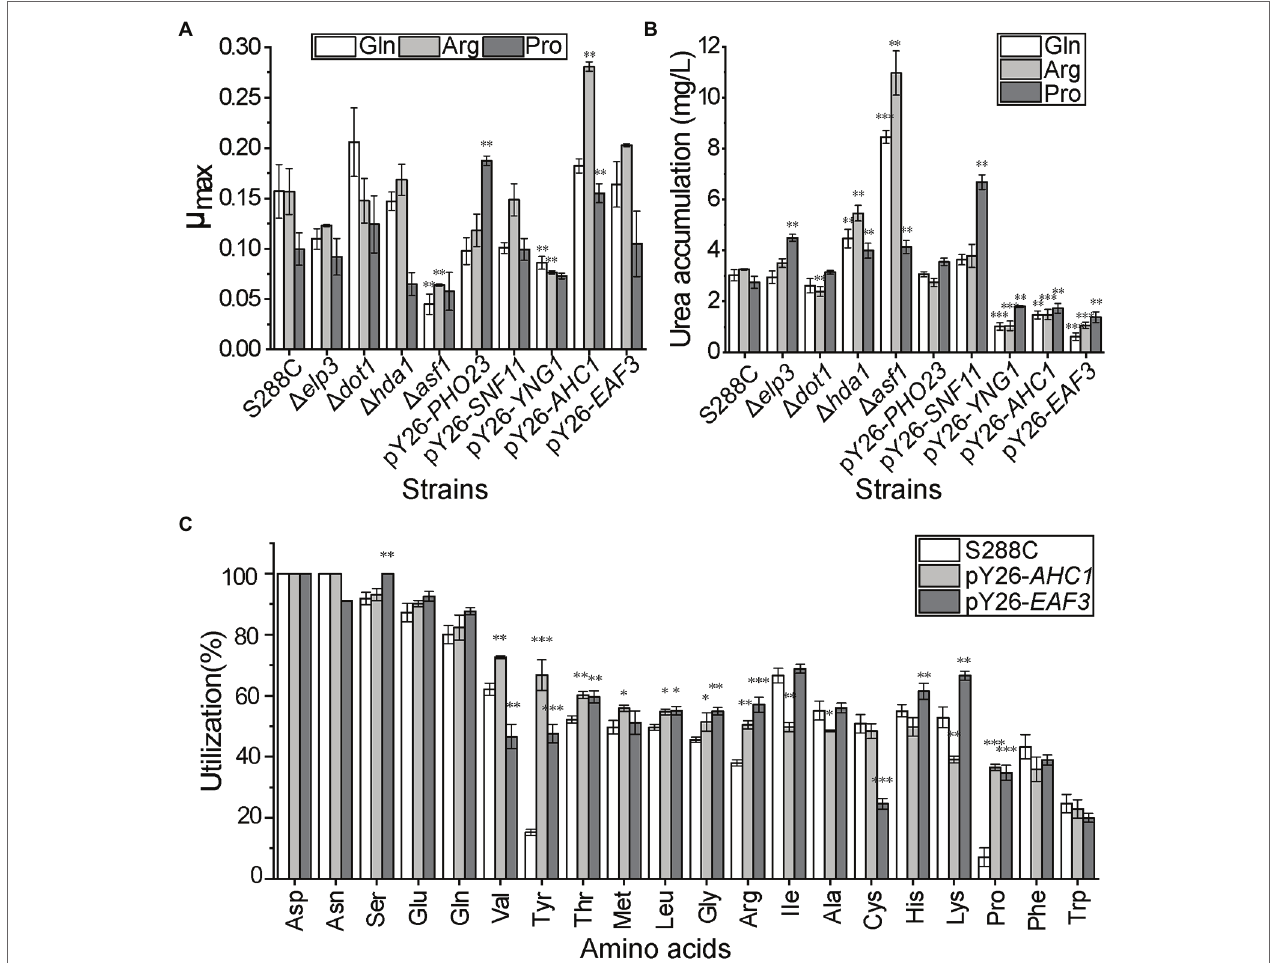
FIGURE 3 | Physiological index analysis of CRs recombinant strains. (A) Growth status of nine CR recombinant strains in the presence of different nitrogen sources. (B) Urea accumulation in nine CR recombinant strains in the presence of different nitrogen sources. (C) Amino acid utilization rate of S288C-pY26- AHC1 and S288C-pY26- EAF3 in mixed medium containing the 20 common amino acids. Results are mean (M) ± standard deviation (SD) of three biological replicates. Statistical significance was determined by unpaired parametric two-tailed Welch’s t -test with 95% confidence (* p < 0.05, ** p < 0.005, *** p <